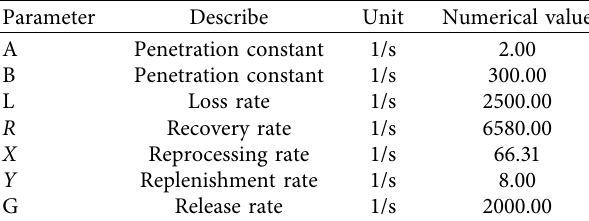
Table 2: Meddis model parameters of inner hair